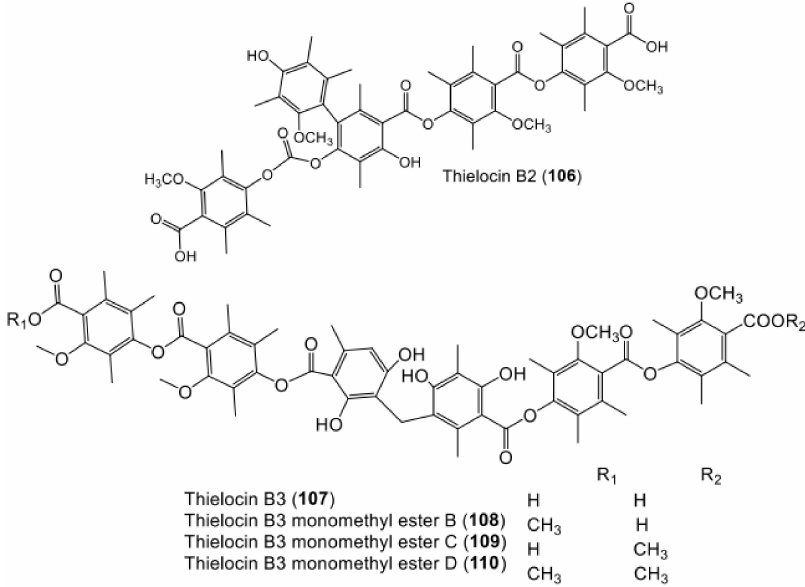
Figure 14. Chemical structures of penta- and hexa-depside 106 – 110